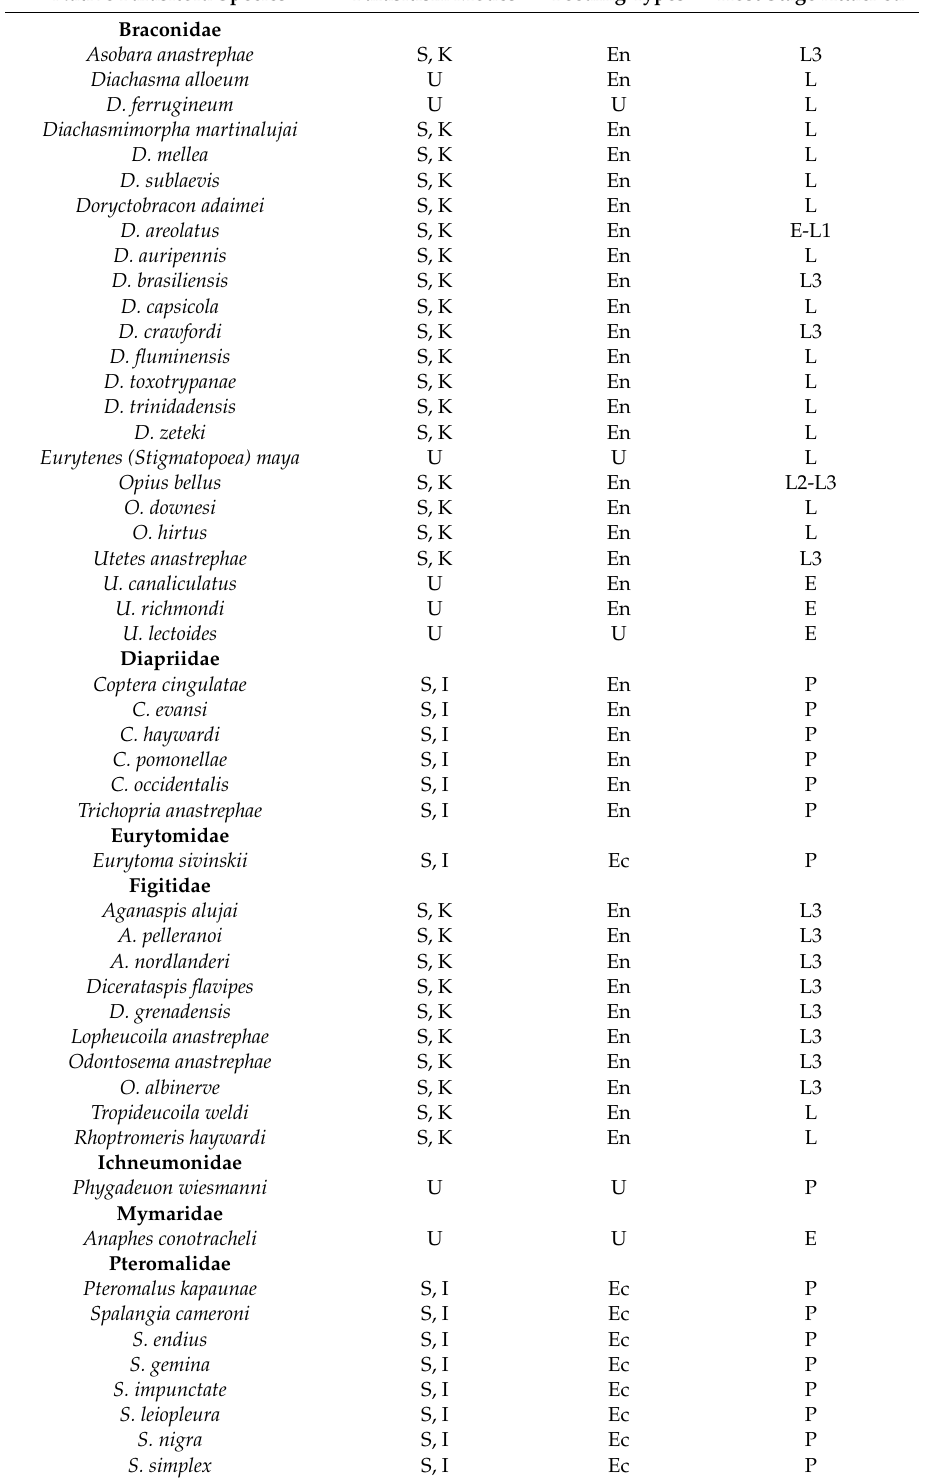
Table 4. Guilds of native parasitoids of tephritid fruit flies with economic importance in the